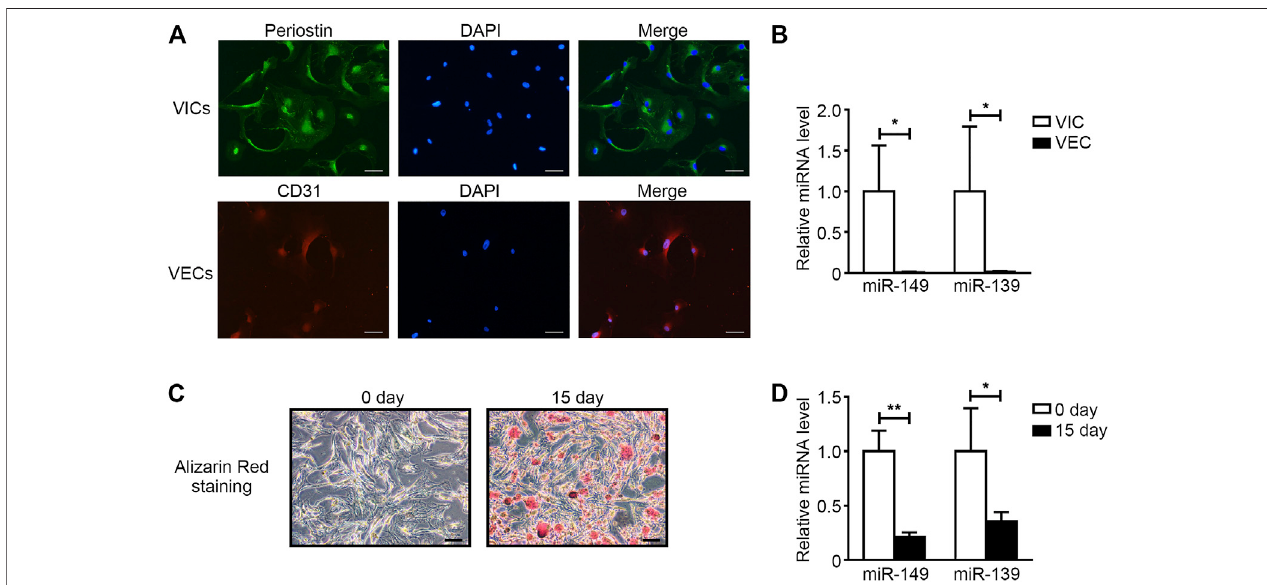
FIGURE 4 | Both miR-149-5p and miR-139-5p were downregulated in osteogenic differentiated VICs signi fi cantly. (A) Primary cultured VICs and VECs were immuno fl uorescencestainedwithPeriostin(green)andCD31(red),respectivelyandthenucleuswasstainedwithDAPI(blue)(thescalebar (cid:2) 50 μ m). (B) Theexpression levels of hsa-miR-149-5p (miR-149) and hsa-miR-139-5p (miR-139) in VECs and VICs were accessed by qRT-PCR and normalized with U6 ( n (cid:2) 4 samples from independent wells in each group). (C) Alizarin red staining was used to access the matrix calcium deposition in VICs at 15 days after OM induction. (D) The expression levels of hsa-miR-149-5p and hsa-miR-139-5p in control and osteogenic differentiated VICs were accessed by qRT-PCR and normalized with U6 (n (cid:2) 4 samples from independent wells in each group). Unpaired Student ’ s t -test, * p < 0.05, ** p <